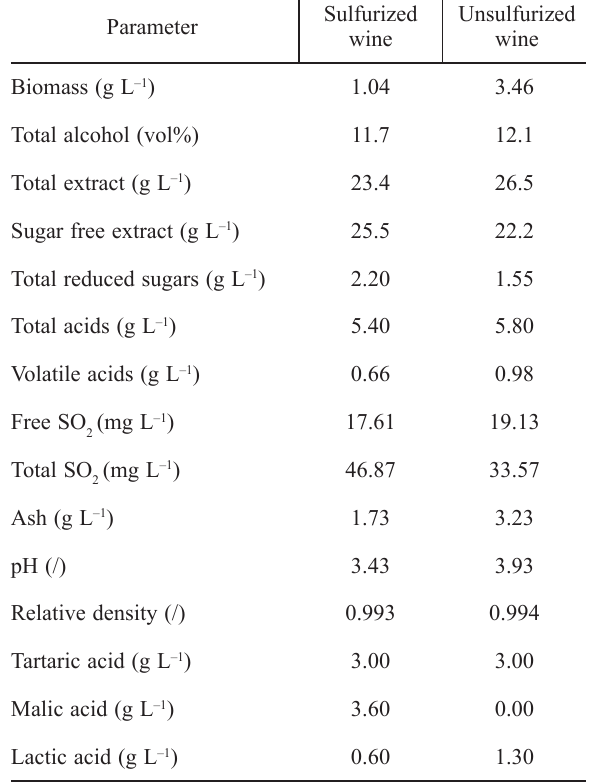
Table 1 – Redox potential layers in the barrels: a) unsulfur- ized, and b) sulfurized wine (a) Unsulfurized must layers